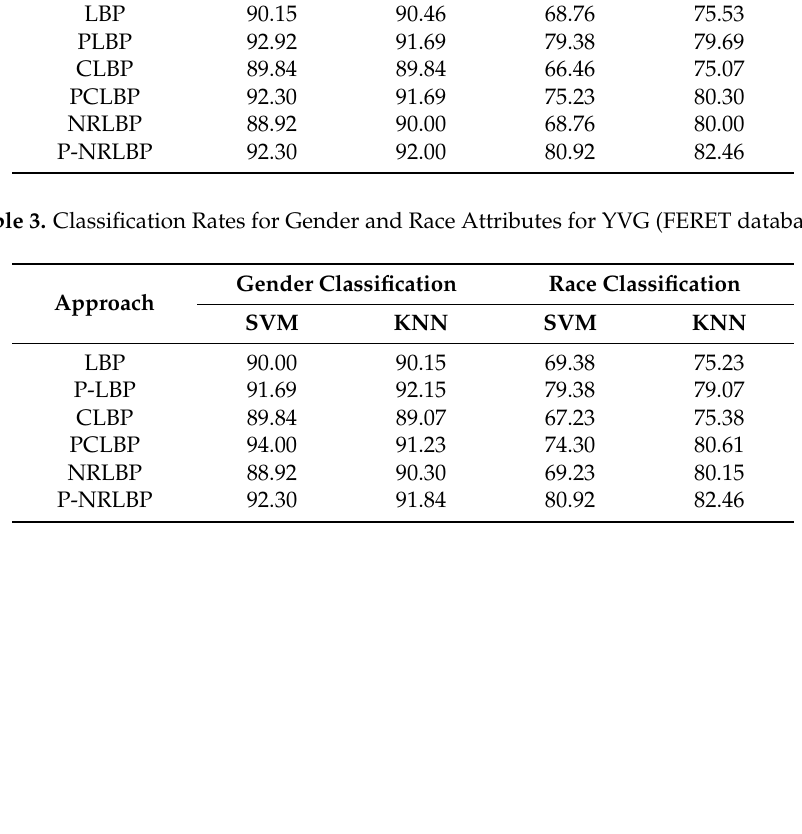
Table 2. Classification Rates for Gender and Race Attributes for YVCb (FERET database). Local Binary Pattern (LBP); Compound Local Binary Pattern (CLBP); Non-Redundant Local Binary Pattern (NRLBP).